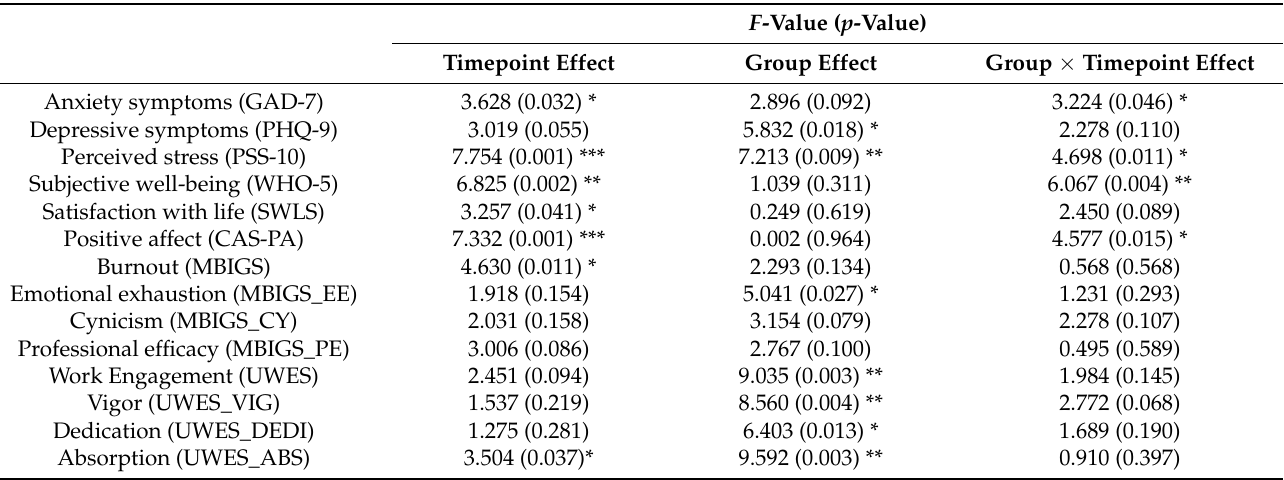
Table 3. Table 2. Results of repeated measures ANOVAs for the effects between groups (program group and control group), across timepoints (T1, T2, and T3), and for group × timepoint interaction. F -Value ( p -Value)